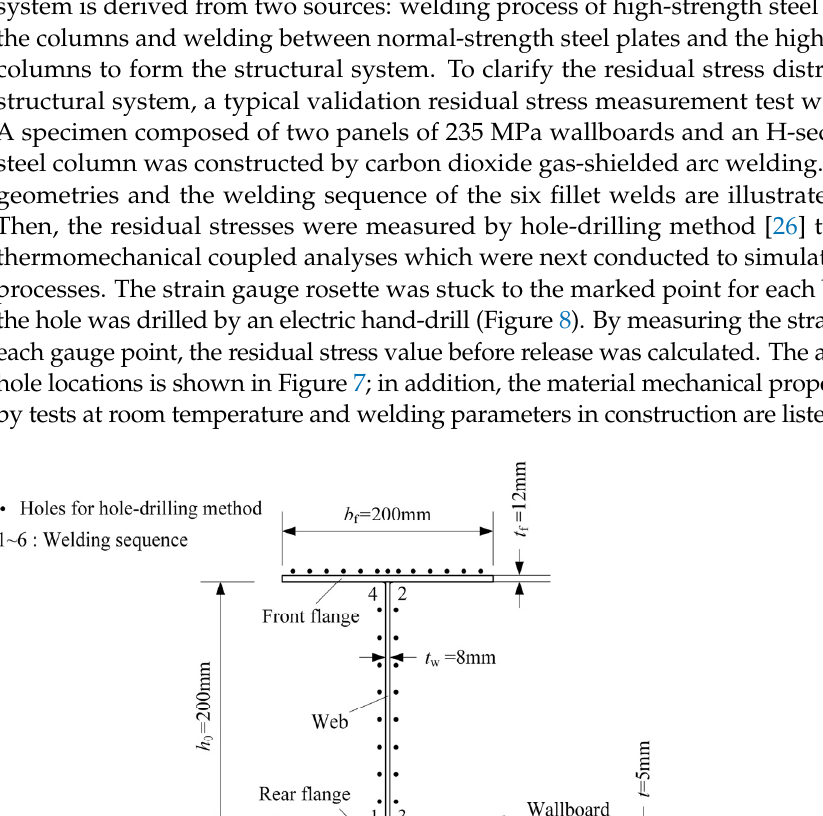
5.67 Figure 8. Welding residual stress measuring test setup of the hole-drilling method.